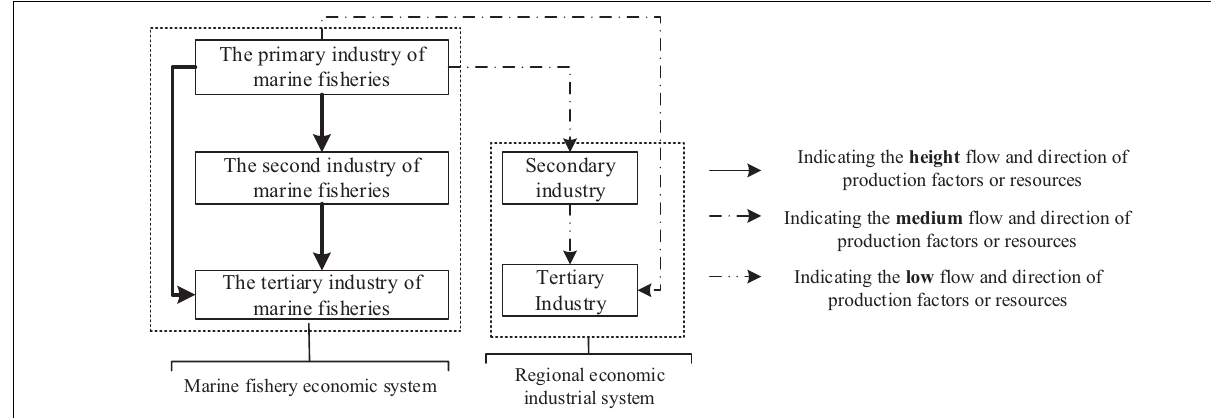
FIGURE 1 | The path of TH affects the economic growth of marine fisheries.